Question: What caption would you write for this figure?
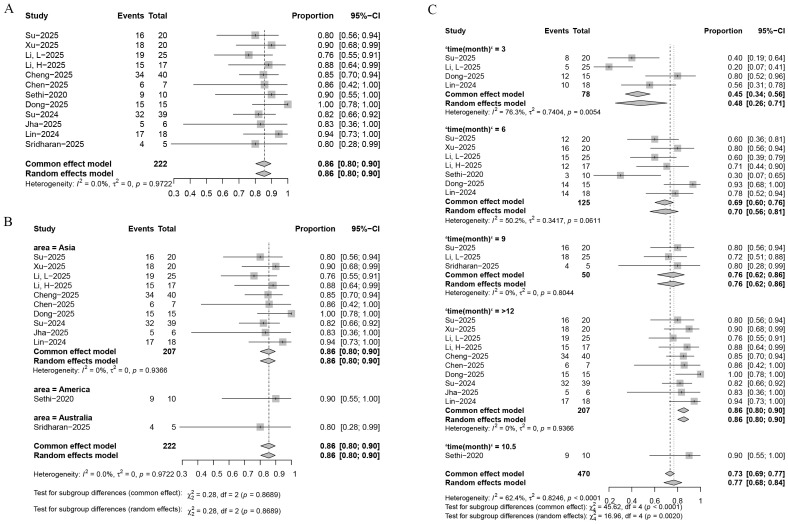
Answer: (A) Forest plot of the overall clinical remission rate; (B) Forest plot of the subgroup analysis of area for the overall clinical remission rate; (C) Forest plot of the subgroup analysis of follow-up time for the overall clinical remission rate.